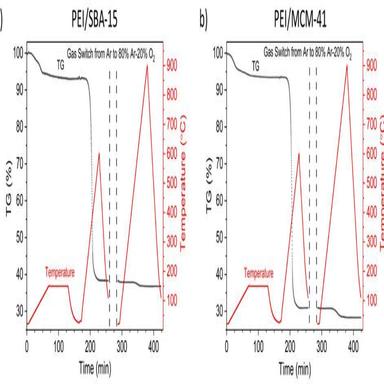
Representative thermal stability results for (a) PEI/SBA-15 and (b) PEI/MCM-41 merged from two separate measurements, with the first measurement in ultra-high purity (UHP) argon and the second measurement in UHP gas mixture (80 % UHP argon and 20 % UHP oxygen).